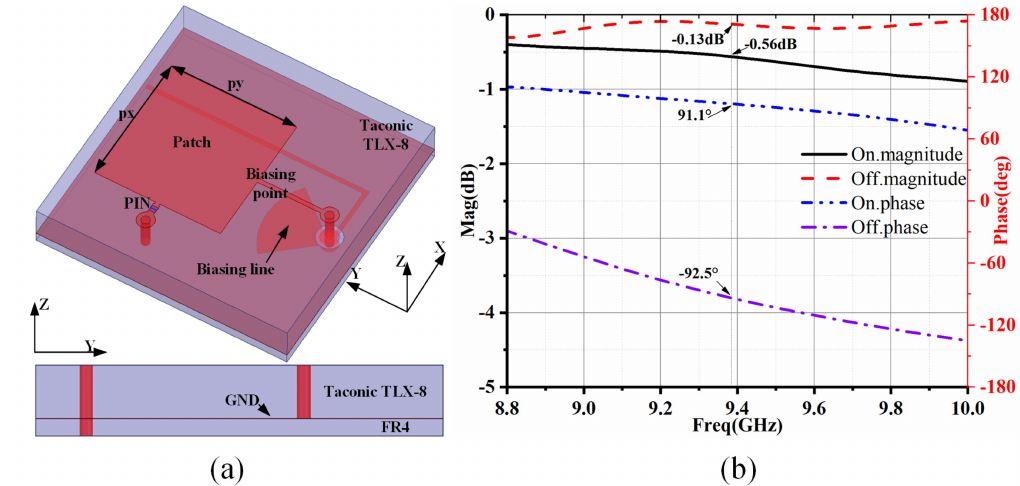
Figure 2. 1-bit reconfigurable element: ( a ) geometrical structure; ( b ) simulated magnitude and phase curves in two states.